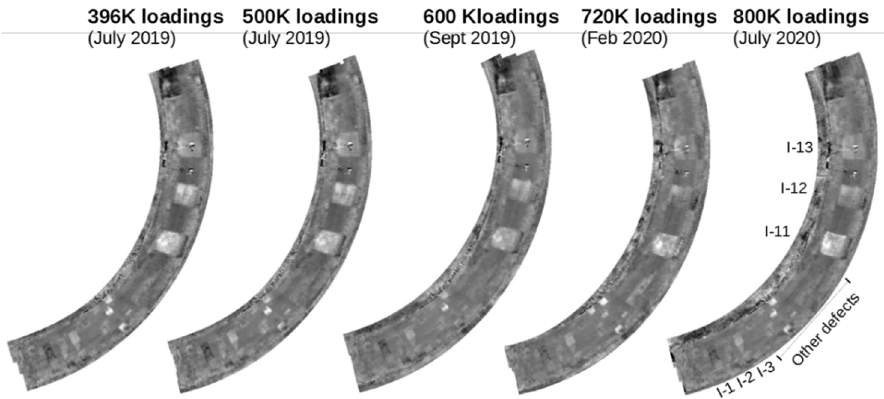
Figure 9. RW amplitude maps of the global test zone at the defect depth, extracted from 1.5 GHz C-scans.